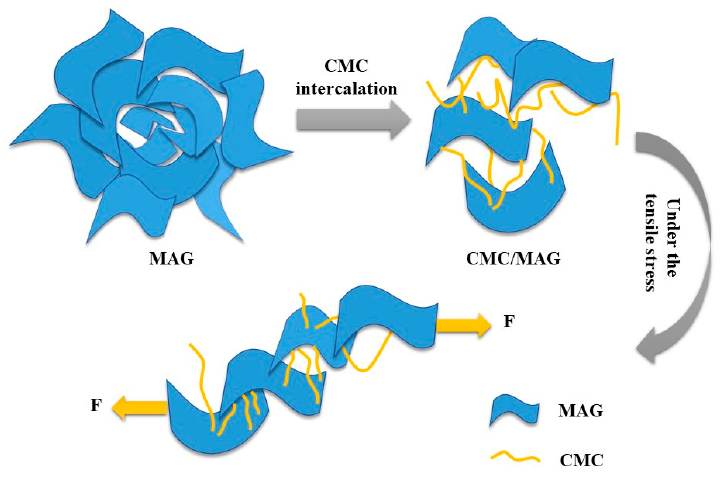
Figure 3. Schematic diagram of microstructure of CMC/MAG.